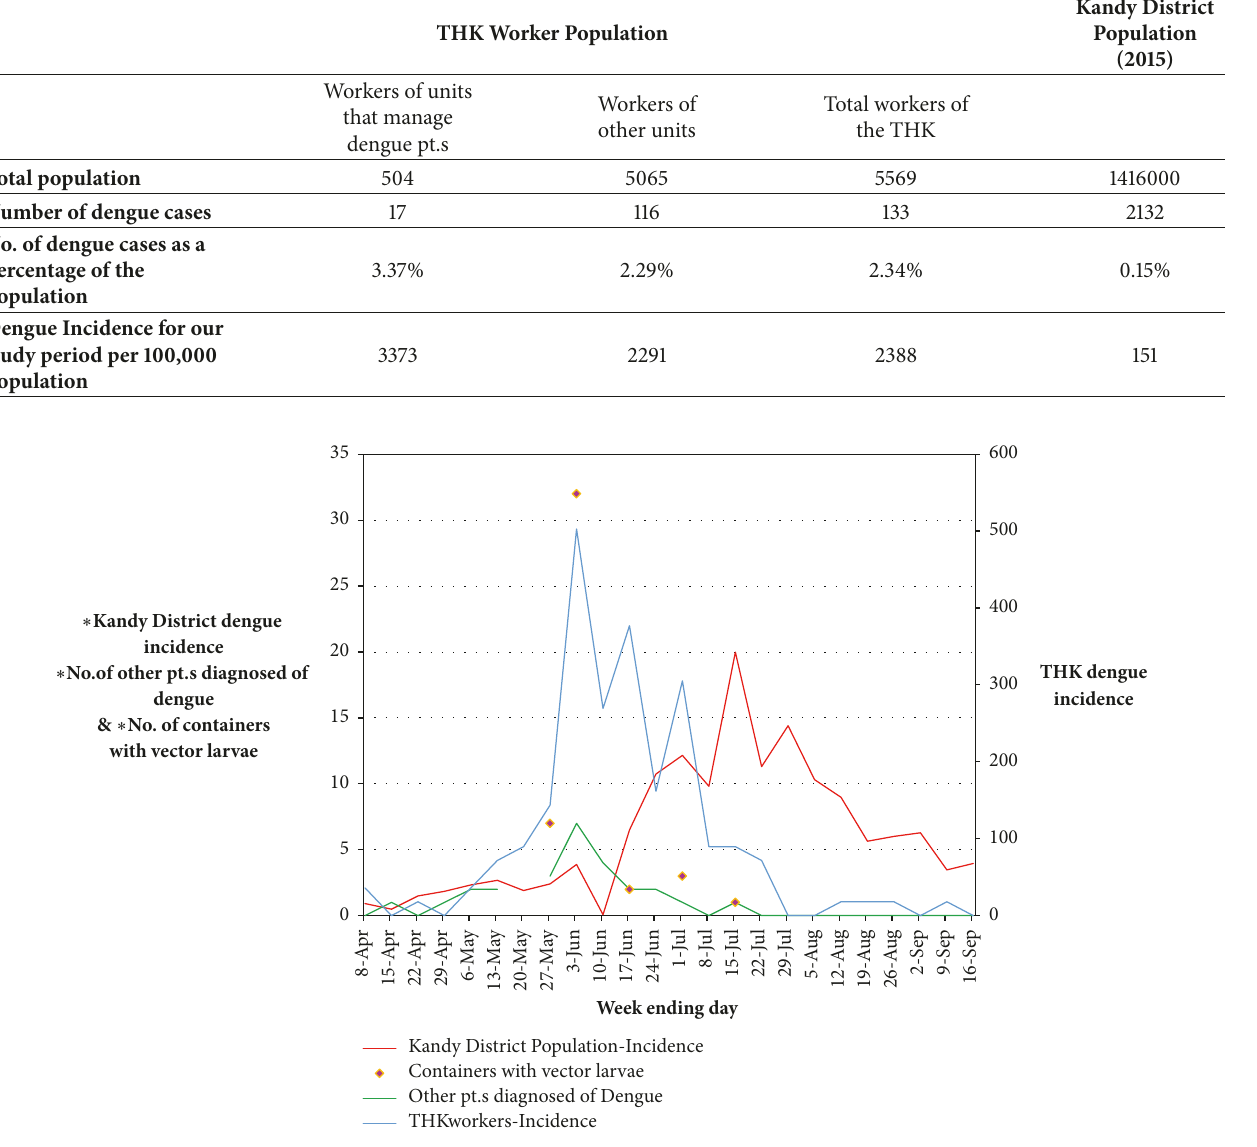
Figure 2: Temporal sequence of weekly dengue incidences of the THK workers, Kandy district population, counts of patients admitted to THK for other illnesses and then diagnosed with dengue each week, and the numbers of containers positive for vector mosquito larvae found in the hospital premises. X-axis: the last day of the each week. Primary Y-axis: dengue incidence per 100000 population in the Kandy district (in red), the numbers (counts) of patients admitted to THK for other illnesses and then diagnosed with dengue each week (in green), and the numbers of containers with vector larvae found in THK premises (in purple). Secondary Y-axis: dengue incidence per 100000 population in THK workers in a different scale (in